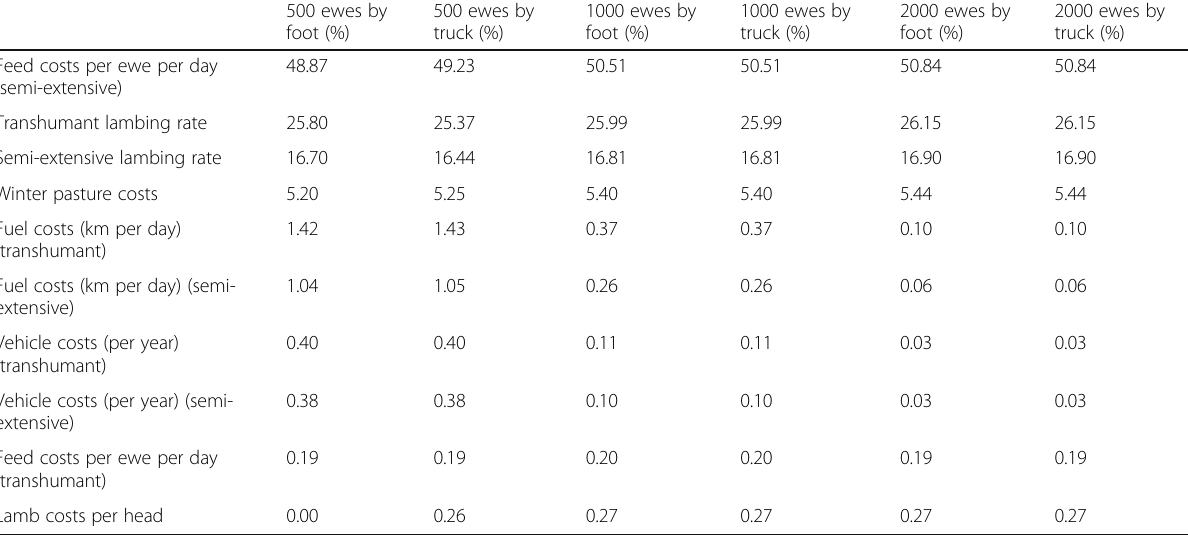
500 ewes by 500 ewes by foot (%) truck (%)